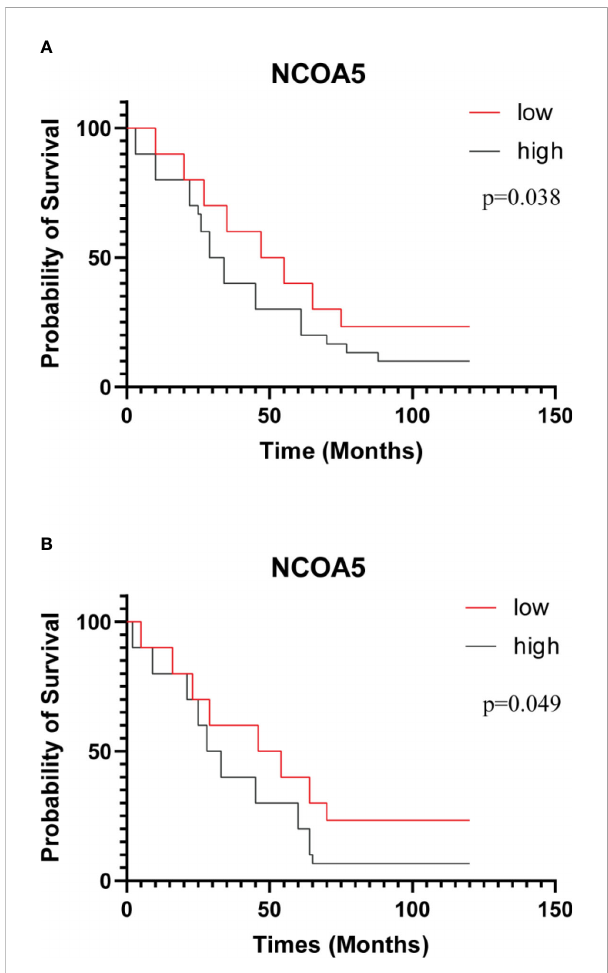
FIGURE 3 Kaplan-Meier curves of OS (A) and PFS (B) after surgery for all patients. patients with low expression of NCOA5 had signi fi cantly longer survival than high expression of NCOA5 (p=0.038 、